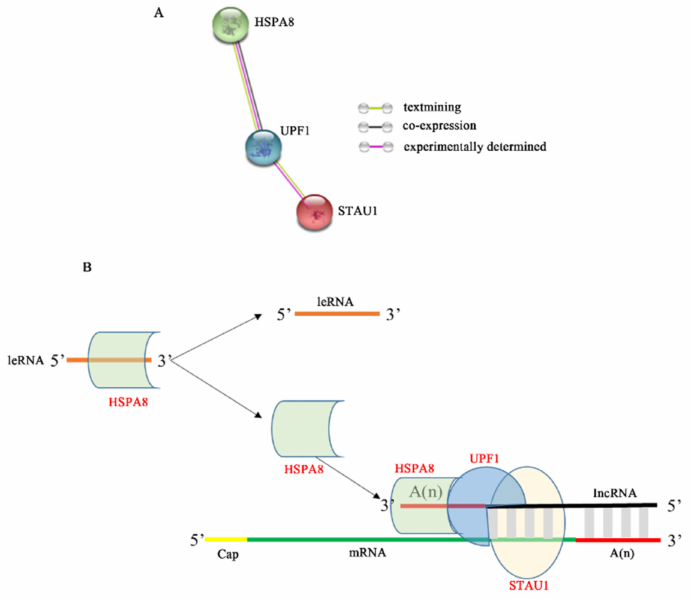
Figure 6. Mechanism model of STAU1 inhibiting RABV replication. ( A ) HSPA8, UPF1, and STAU1 protein interactions. ( B ) The model of STAU1 inhibits RABV